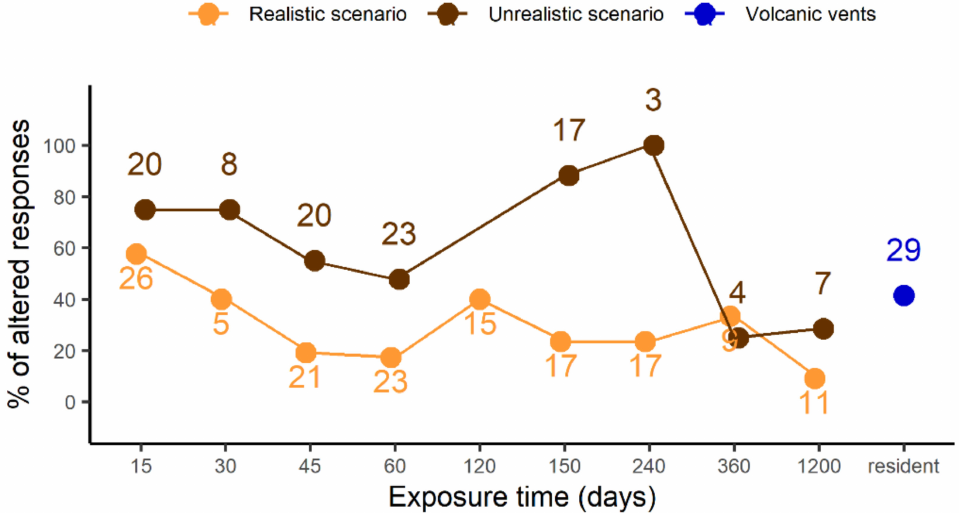
Figure 2. Percentage of altered responses compared with control conditions in sea urchins maintained under either realistic or unrealistic 2100 scenarios (IPCC RCP8.5) along time of exposure (not scaled). Close to each dot, the number of endpoints per case is